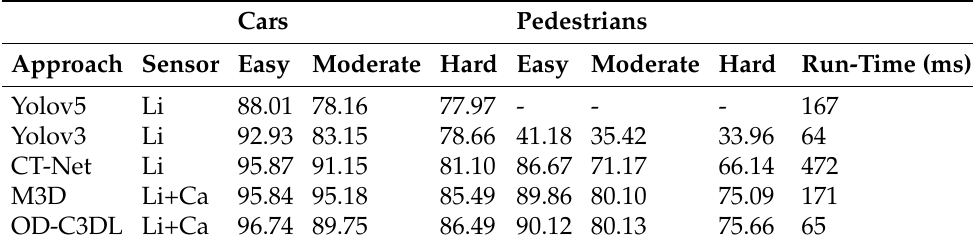
Table 3. On the KITTI dataset, Average-Precision (AP) (percent) was calculated using earlier LiDAR- and image-based techniques. LiDAR and camera sensors are indicated by the letters Li and Ca, respectively.